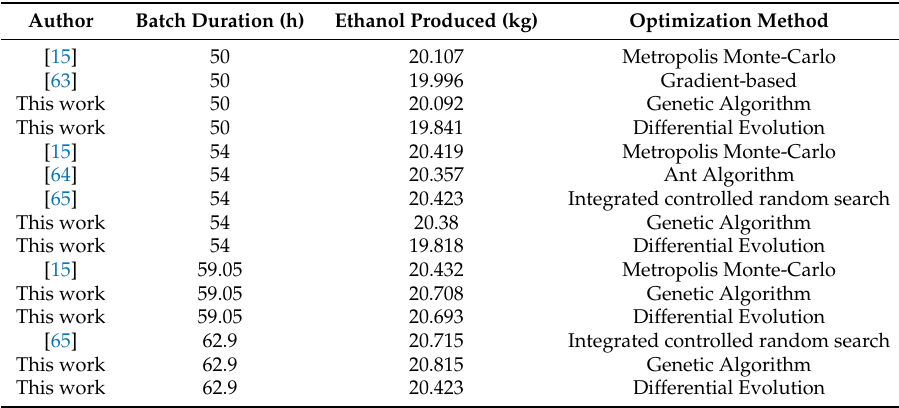
Table 11. Results obtained for the open-loop optimization, comparing between GA and DE optimization algorithms.